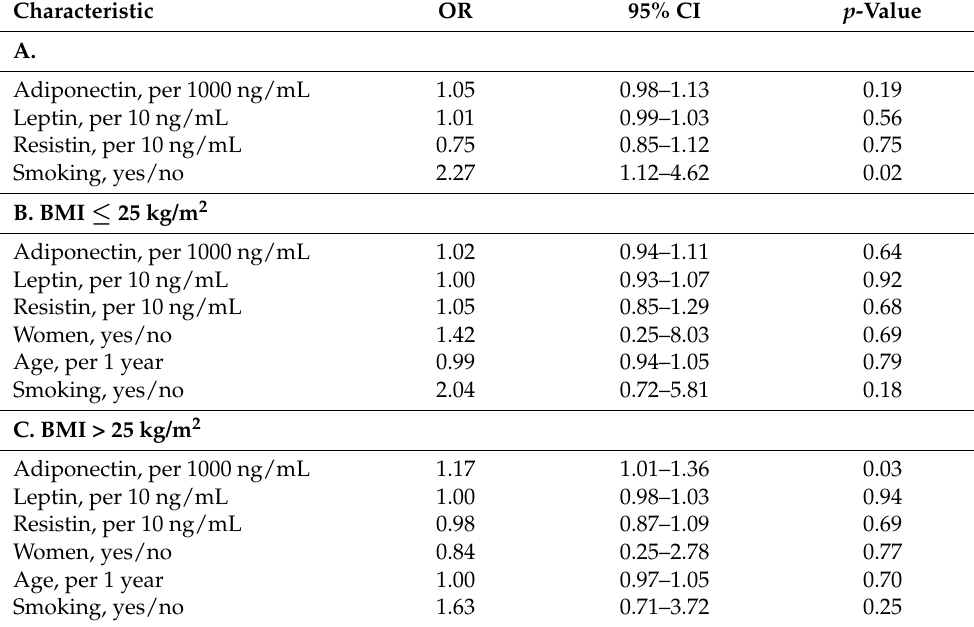
Table 4. Multivariable conditional logistic regression analysis for RA risk (A) and logistic regression analyses after stratifying for BMI (B and C) in the Medical Biobank of Northern Sweden cohort. Characteristic